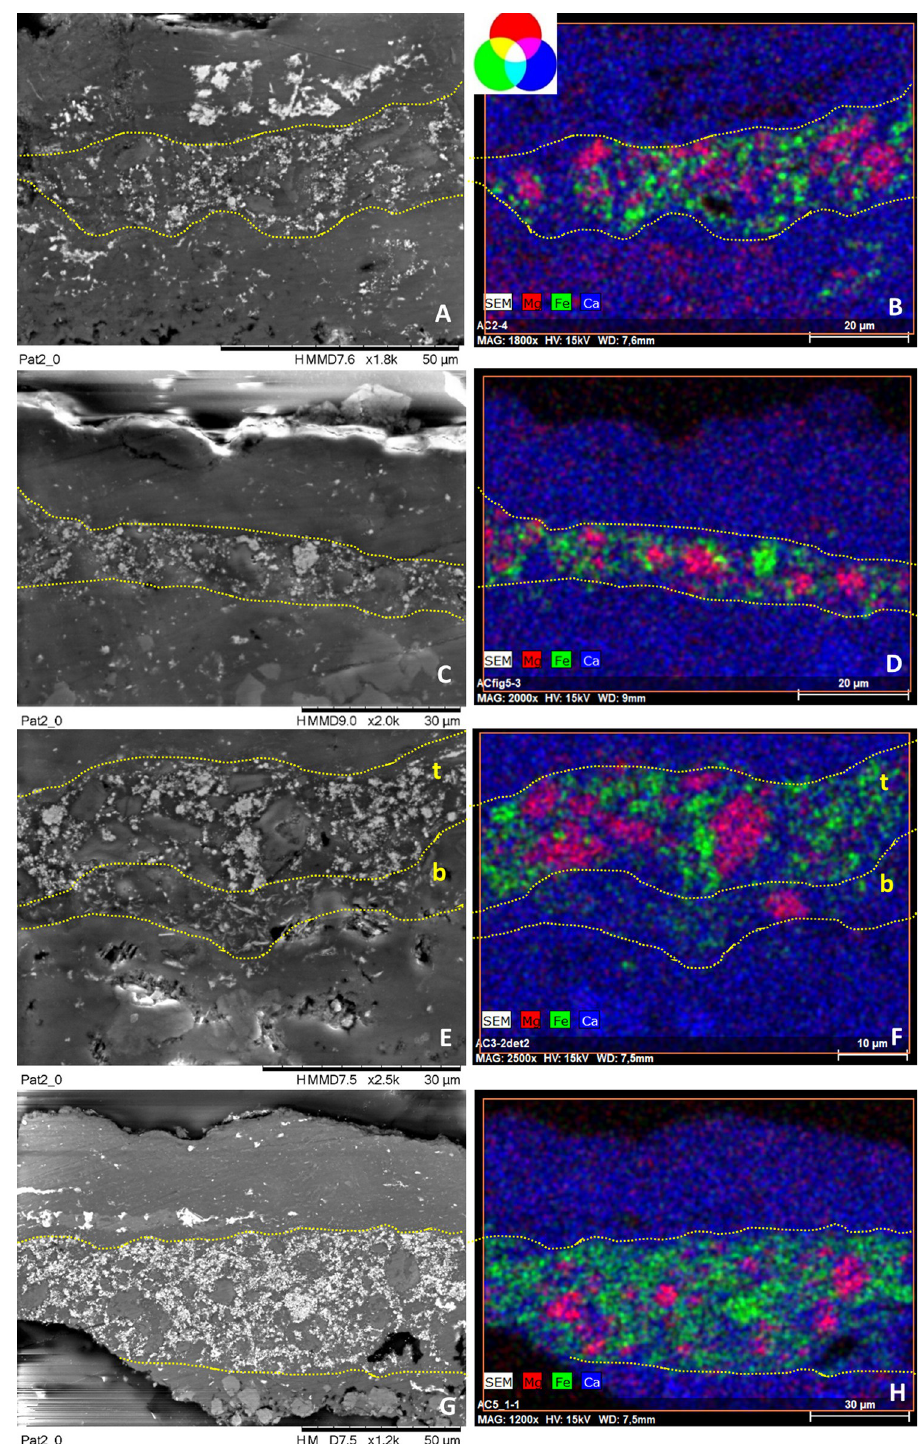
Fig 6. SEM backscattered images and their RGB composite images of the elemental distribution of Mg K α /Fe K α / Ca K α of a selected area of cross-sections AC2.1 (images A-B), AC2.2 (images C-D), AC3 (images E-F), AC5.1 (images G-H) constitutive of group 1. See S1 Figs 6 and 8 in S1 File to visualize the location of the analyzed areas within the cross-section (framed by red